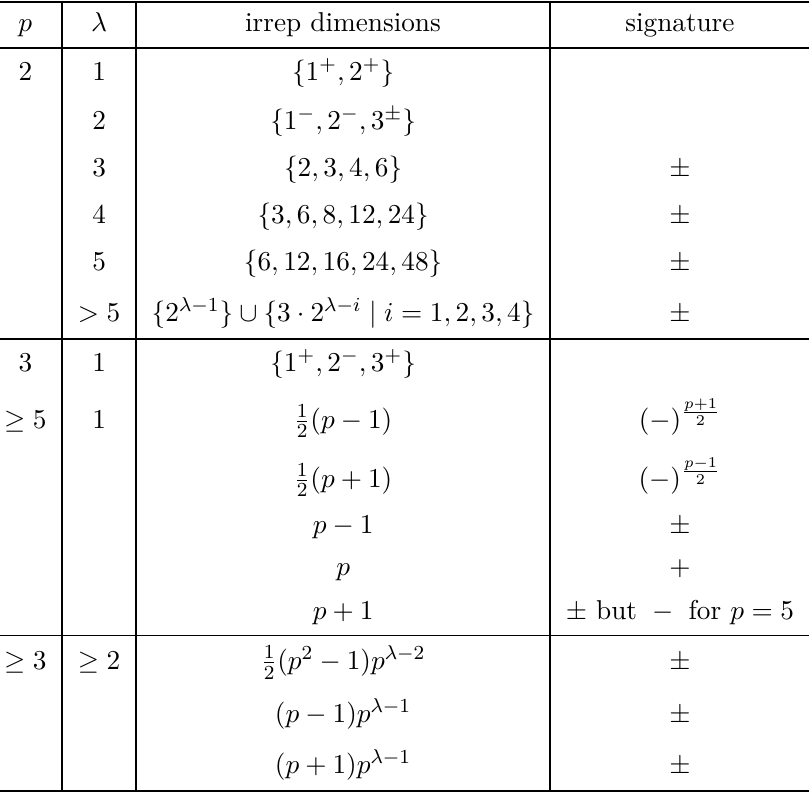
) → GL( d, C ) that p λ ) → GL( d, C ) under the quotient p λ − 1